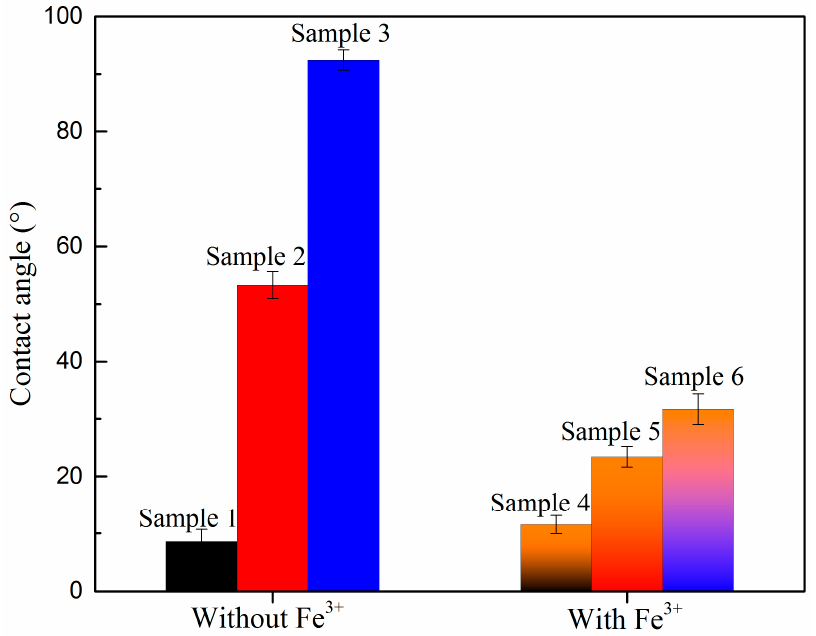
Figure 7. Contact angle of oxidized digenite fine particles with different treatments (Sample 1: with DI water; Sample 2: with 1.25 × 10 − 3 mol/L Na 2 S; Sample 3: with 1.25 × 10 − 3 mol/L Na 2 S + 1 × 10 − 4 mol/L SBX; Sample 4: with 1 × 10 − 3 mol/L Fe 3+ ; Sample 5: with 1 × 10 − 3 mol/L Fe 3+ + 1.25 × 10 − 3 mol/L Na 2 S; Sample 6: with 1 × 10 − 3 mol/L Fe 3+ + 1.25 × 10 − 3 mol/L Na 2 S + 1 × 10 − 4 mol/L SBX).